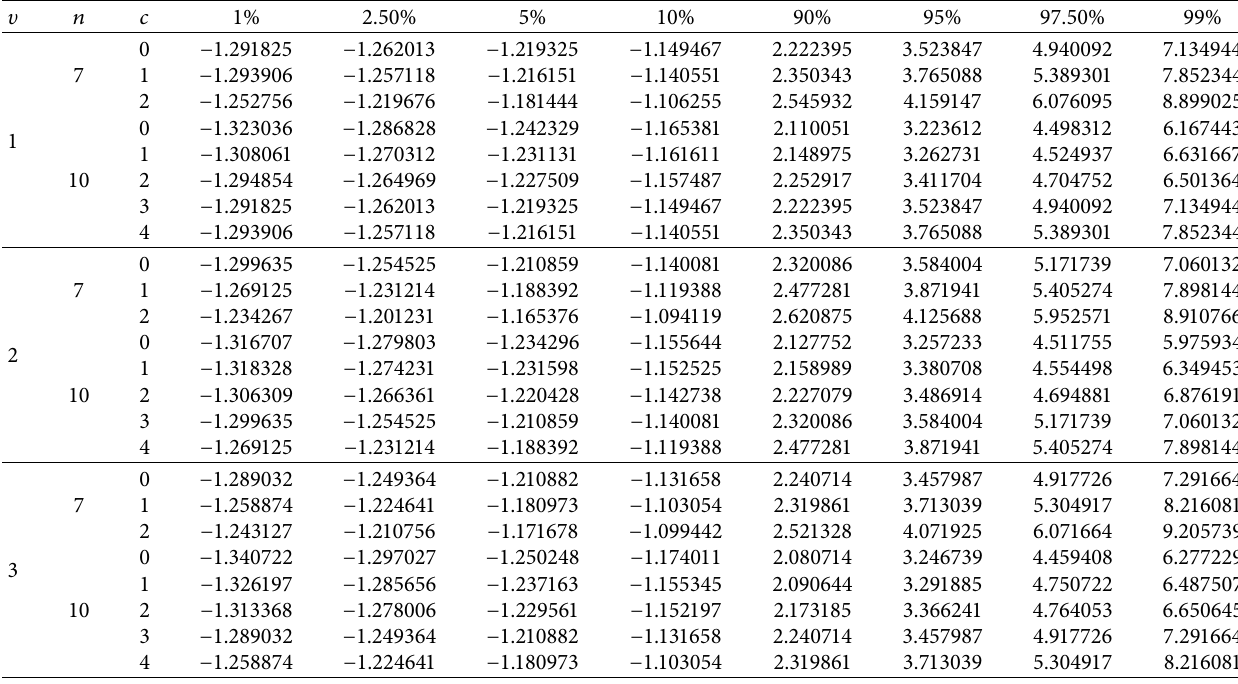
when μ � 0 and σ � 1. 3